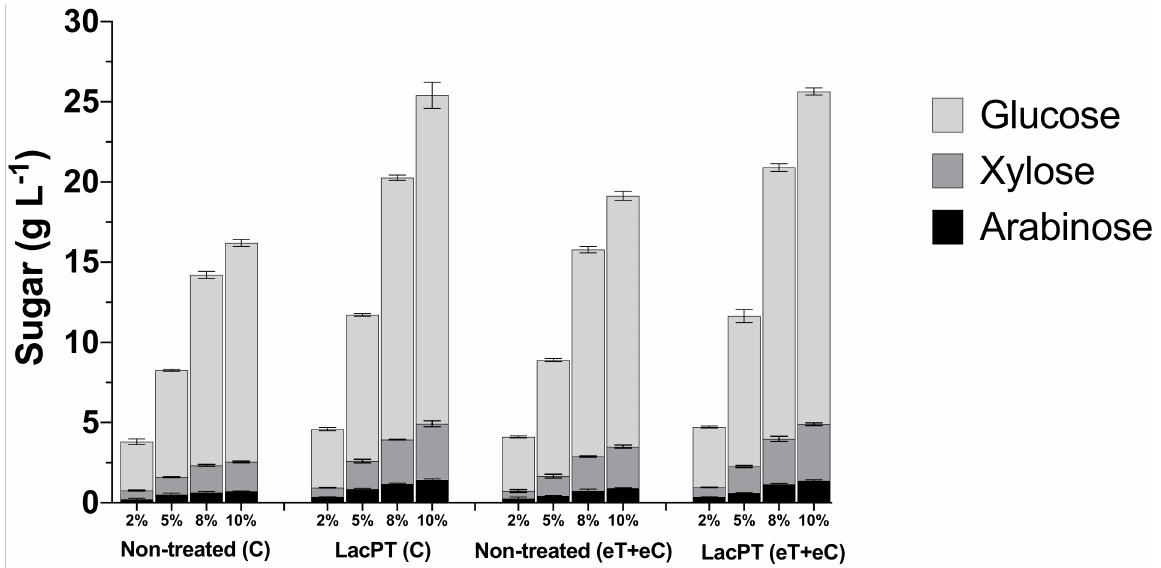
Figure 7. Glucose, xylose, and arabinose yield (g L − 1 ) after enzymatic hydrolysis of non-treated (C and eT+eC) and laccase pretreated (C and eT+eC) biomass at 2, 5, 8, and 10% solid load. Hydrolysis conditions: 15 mg protein/ g biomass for 48 h. Treatments: Control (C) and elevated temperature+elevated CO 2 (eT+eC). Mean values ± SD ( n = 3). The p -value was calculated using Tukey’s test and is discussed in the text at the proper place ( p -value, significant <